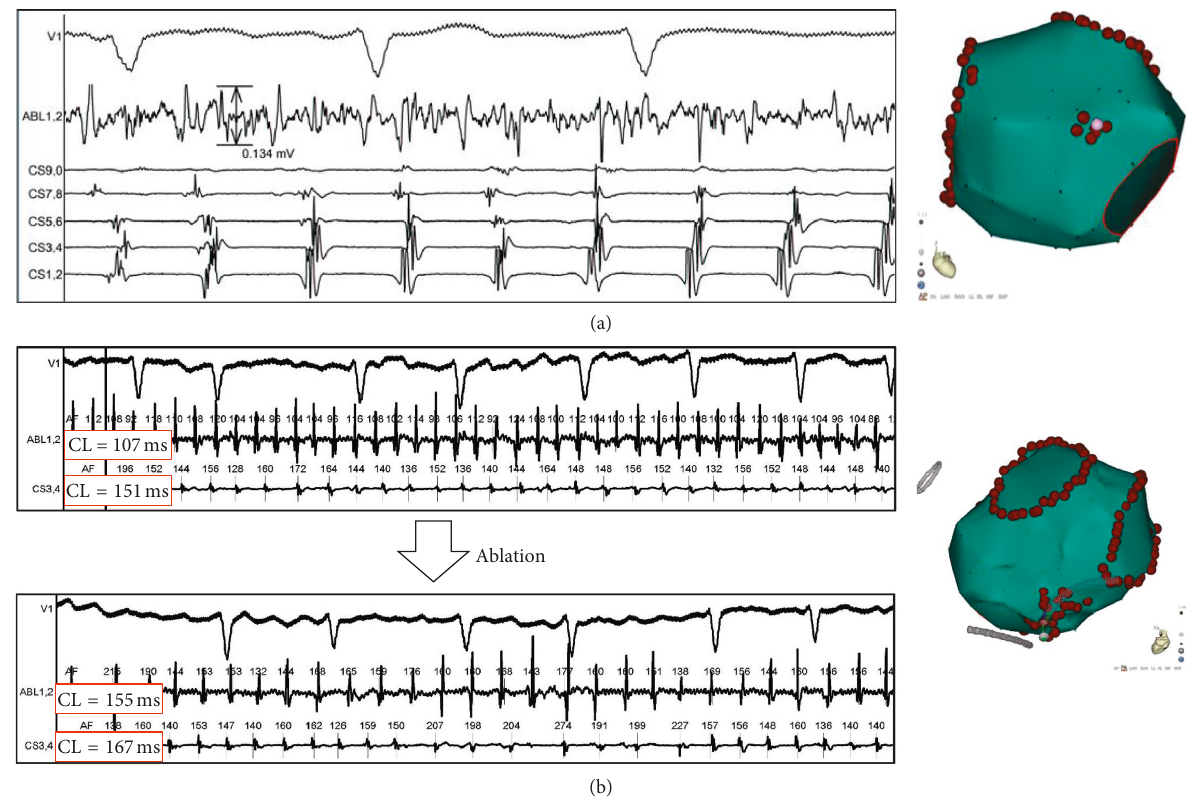
Figure 2: Examples of ablation targets. (a) Surface ECG lead V1, intracardiac recordings from an ablation catheter (abl), and a mapping catheter within the coronary sinus (CS). Note that, after circumferential pulmonary vein isolation (CPVI) and ibutilide, the atrial activity with CS had become very organized; however, an area on the anterior wall of the left atrium (LA) still presented with continuous, low- voltage (0.134mV), and fractionated atrial electrograms. (b) Surface ECG lead V1 and intracardiac recording from an ablation catheter and CS 3-4 electrodes. After CPVI and ibutilide, the local atrial fibrillation cycle length (AFCL) was 107ms on the lower part of the posterior wall of the LA, whereas the AFCL recorded by the adjacent CS catheter was more rapid (151ms) (top). After ablation, the local AFCLs at the ablation site and CS were prolonged to 155 and 167ms, respectively (bottom).